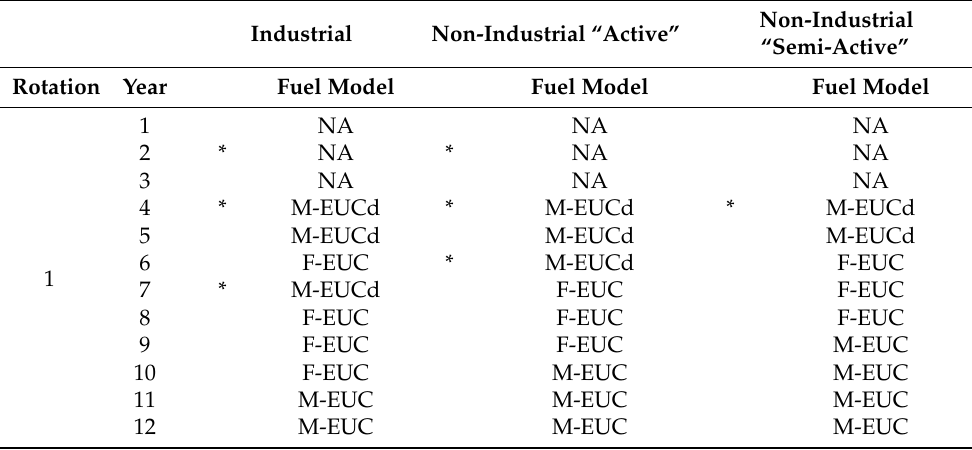
Figure A2. Fuel treatment area size distribution related to the increase in forest stand management strategy. Table A1. Fuel model distribution across time for three eucalypt rotations: industrial FMA and non-industrial “active” and “semi-active” FMA. Acronyms are explained in Table 1 of the main text.